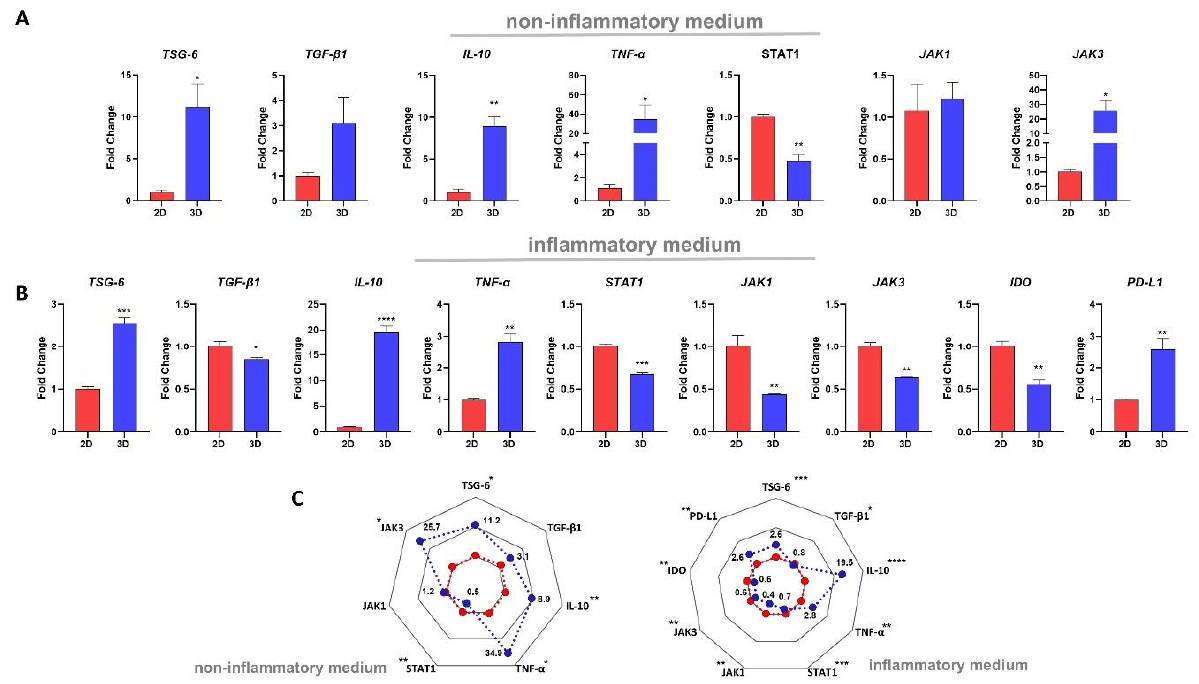
Figure 4. Transcriptional profile of 2D-MSCs and 3D-MSCs cultured in inflammatory or non- inflammatory conditions. ( A ) TSG-6, TGF- β 1, IL-10, TNF- α , STAT1, JAK1, and JAK3 expressions in 2D-MSCs and 3D-MSCs exposed to a non-inflammatory medium. Cells did not express IDO and PD-L1 when in a non-inflammatory medium. ( B ) TSG-6, TGF- β 1, IL-10, TNF- α , STAT1, JAK1, JAK3, IDO, and PD-L1 expressions in 2D-MSCs and 3D-MSCs exposed to an inflammatory medium. The median Ct values obtained 2D-MSCs were used as a reference. ( C ) Radial plot demonstrating non-inflammatory conditions. * p < 0.05; ** p < 0.01; *** p < 0.001; **** p <